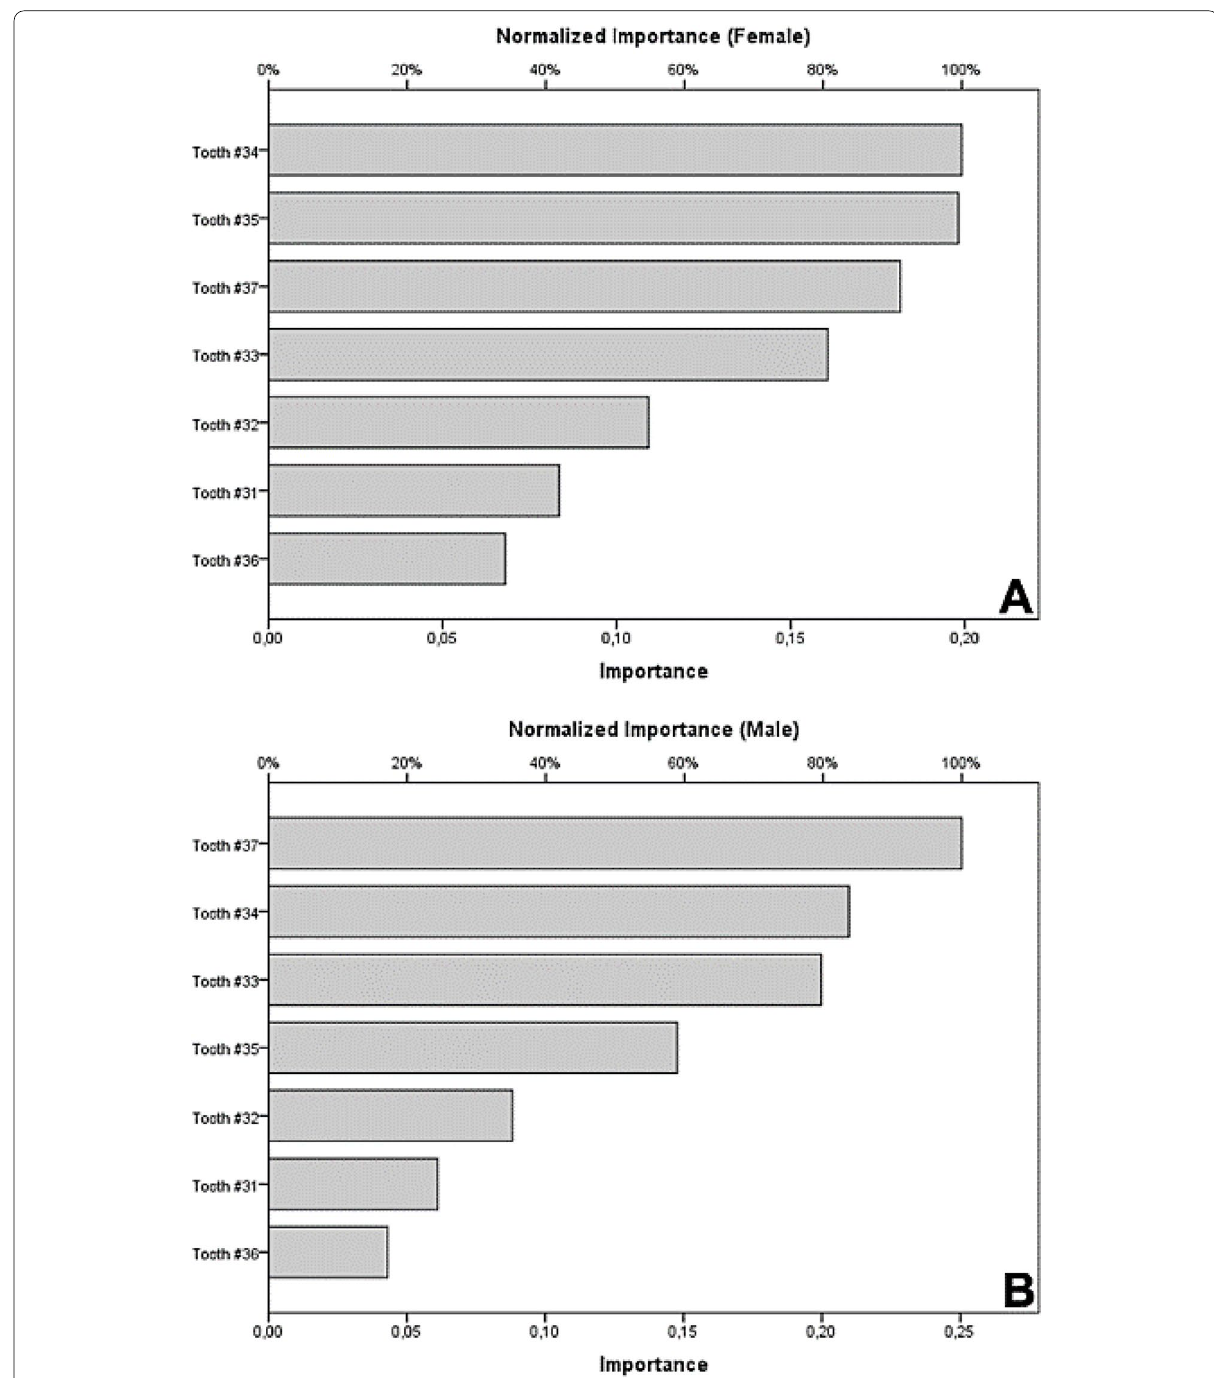
Fig. 2 Artificial neural network (ANN) analysis of the importance the independent variables to estimate chronological age, considering females ( A ) and males ( B ). The bar charts display the importance and the normalized importance for each independent variable in predicting the chronological age. Tooth positions described according to the notation system of the Fédération Dentaire Internationale